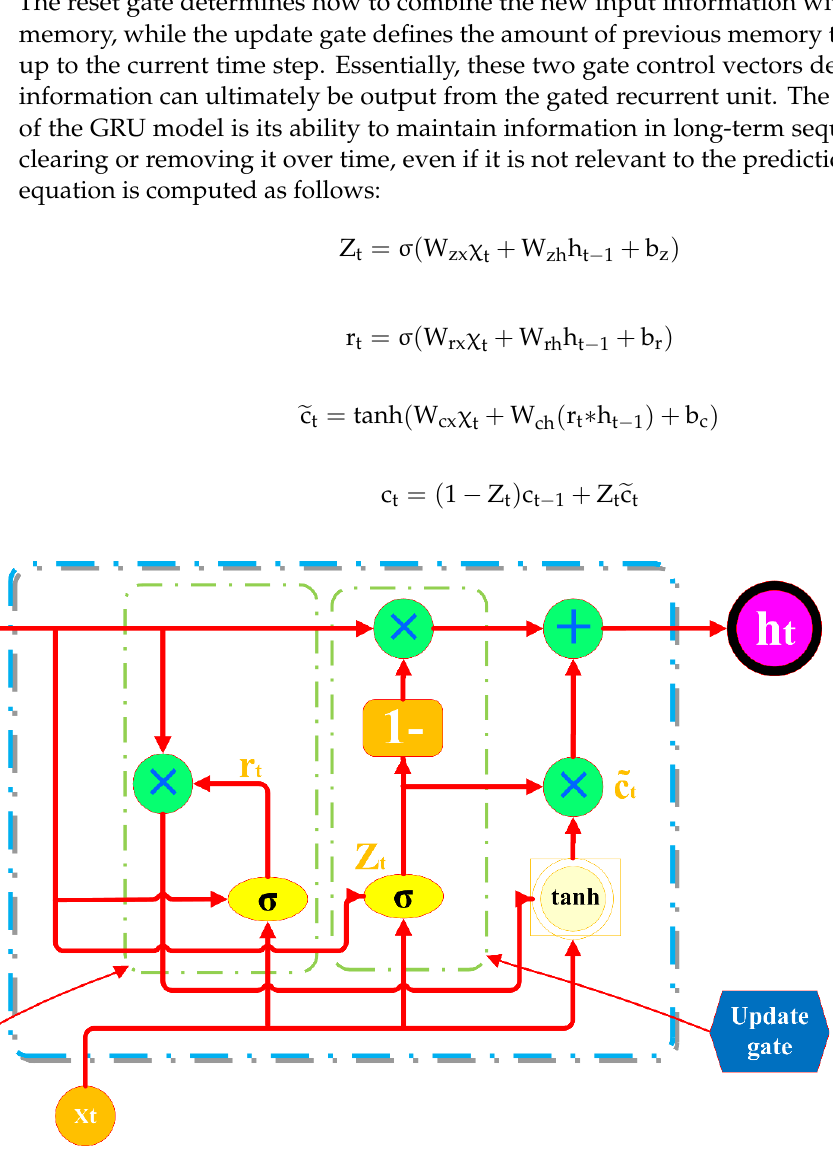
Figure 4. The structure of the GRU neural network.